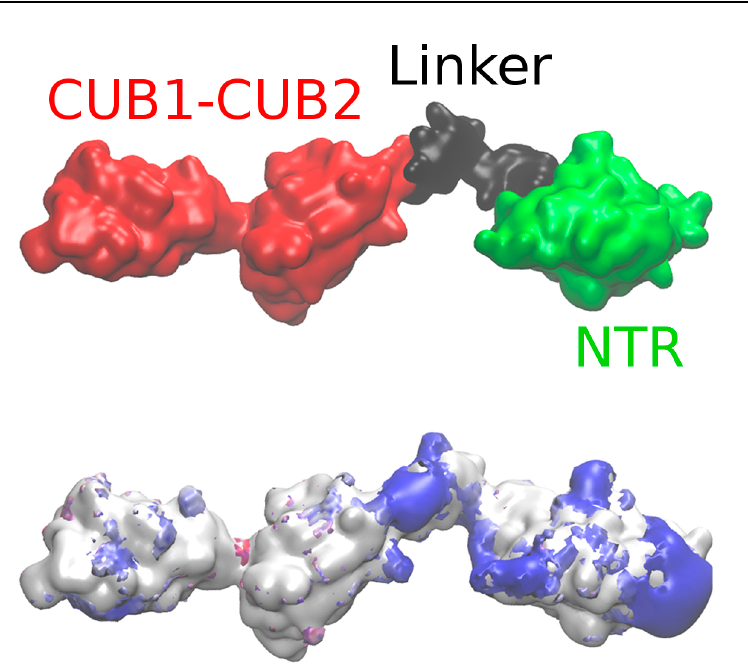
Figure 2. Small angle X-ray scattering (SAXS) Model (upper panel). Netrin-like (NTR) domain: green; CUB1-CUB2: red; the interdomain linker between the CUB2 and NTR domains: black. Positive electrostatic potential isosurfaces (2.0 kcal/mol · e − 1 ) in the absence of Ca 2+ ions obtained by Poisson-Boltzmann surface area (PBSA) calculations (bottom panel).